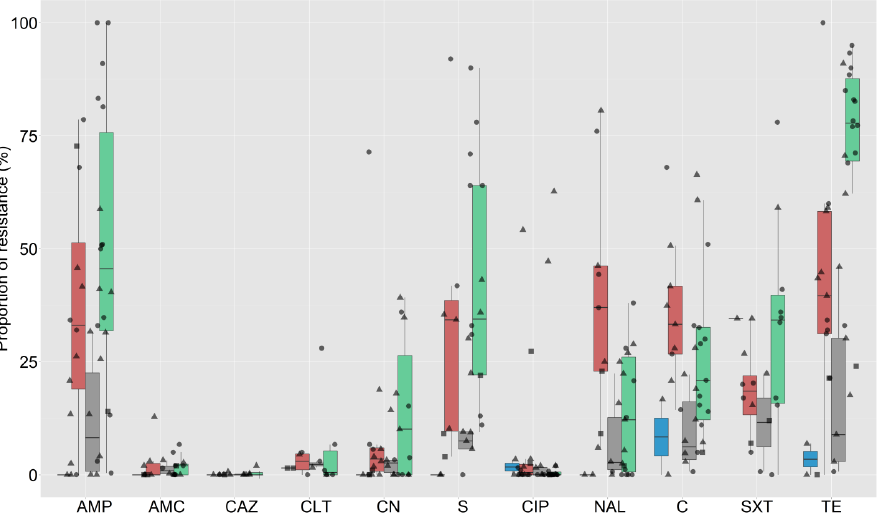
Figure 2. Summary results of estimates of prevalence of AMR in non-typhoidal Salmonella (NTS) isolates of animal origin (N = 41). Blue = aquaculture, Red = chicken, Green = pig, Grey = other species. Circle = Thailand, triangle = Vietnam, square = other countries (Cambodia, Lao PDR, and Malaysia). Key: AMP = ampicillin, AMC = augmentin, CAZ = ceftazidime, CLT = cephalothin, CN = gentamicin, S = streptomycin, CIP = ciprofloxacin, NAL = nalidixic acid, C = chloramphenicol, SXT = co-trimoxazole, TE = tetracycline. Boxplots indicate median and 75% interquartile range.